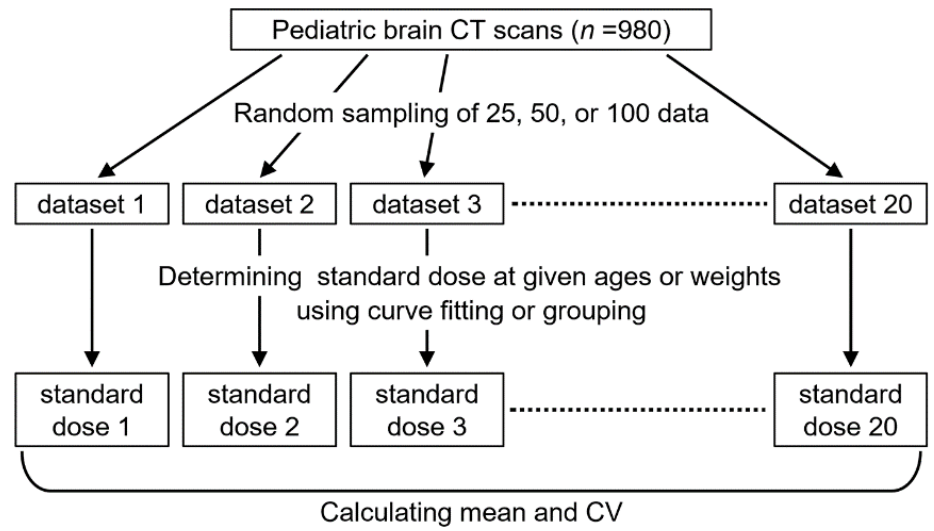
Figure 1. Flowchart of the estimation of standard doses from datasets of different sizes.